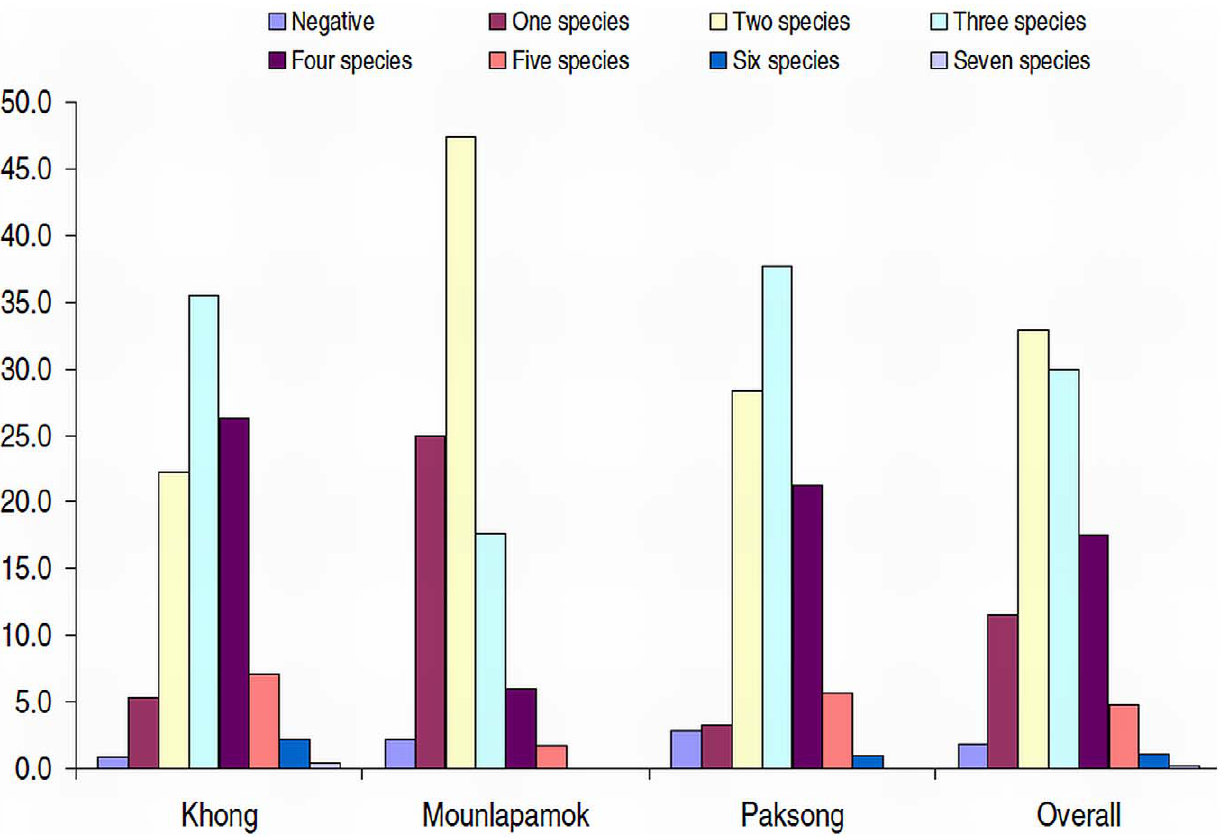
Figure 4. Multiparasitism as assesses by stool examination using two diagnostic methods, stratified by eco-epidemiological setting (n = 669).